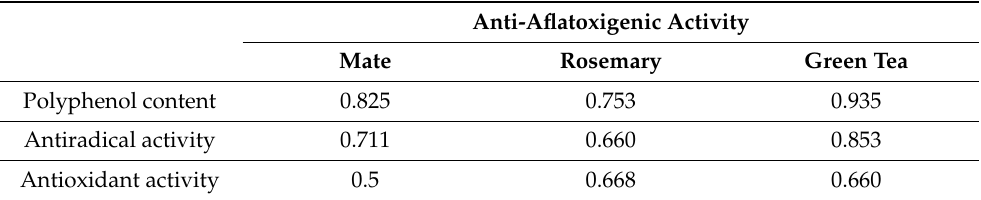
Table 2. Pearson correlation coefficients between anti-aflatoxigenic potential and polyphenol content, global antioxidant activity and antiradical activity for mate, rosemary, and green tea